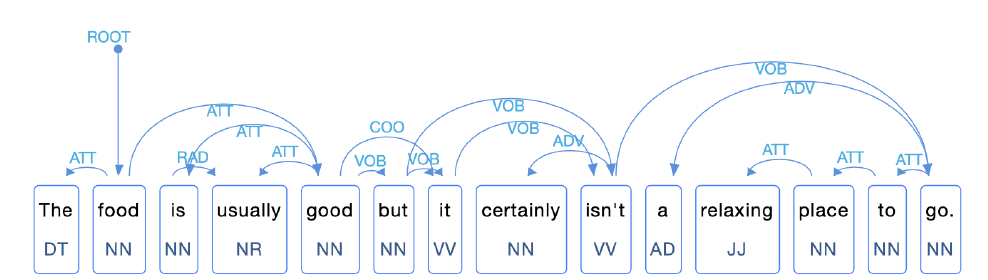
Figure 1. An example of a syntactic dependency parse